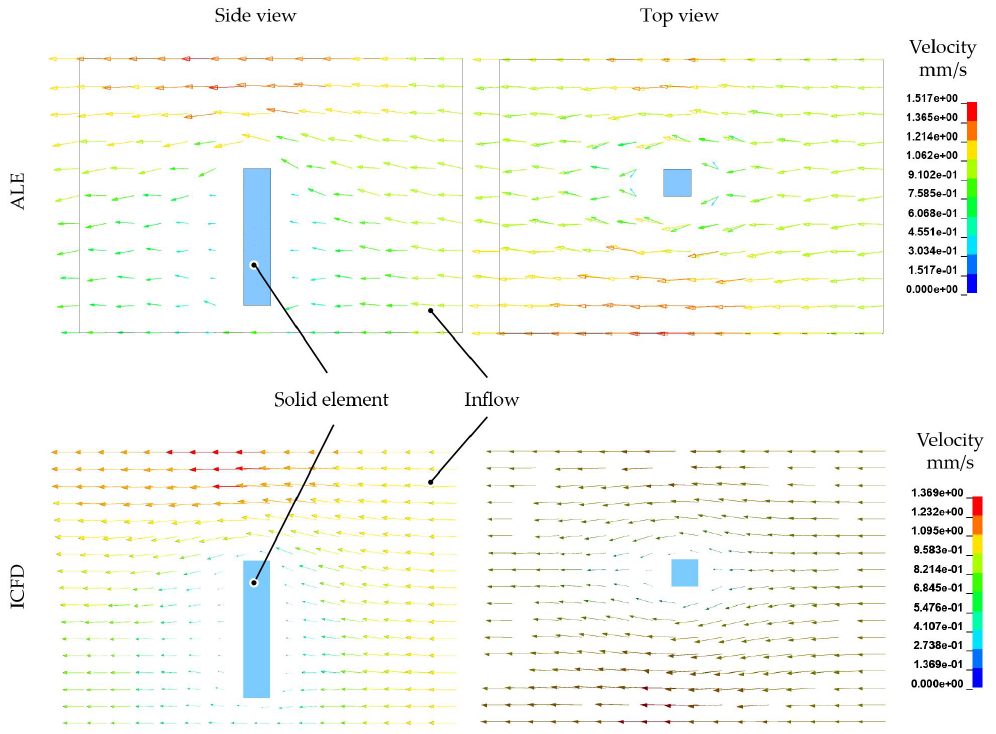
Figure 14. Flow behaviour around solid structures modelled with ALE and ICFD method. Despite the comparison of the flow and velocity profile, the resultant tip deflections and nodal forces at the top is shown in Figure 15. In accordance to the collision model,